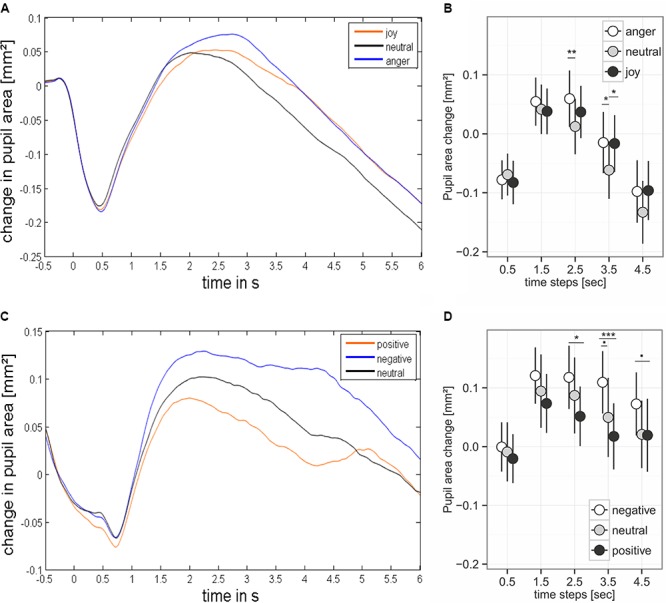
Pupil dilation during presentation of prosodic stimuli (A,B) and sound (C,D). (B,D) Base on mean values ± 95% CI for the analyzed time steps. Stimulus onset happened at time point 0. Asterisks mark the significance levels of the post hoc tests: .p < 0.1, ∗p < 0.05, ∗∗p < 0.01, ∗∗∗p < 0.001.